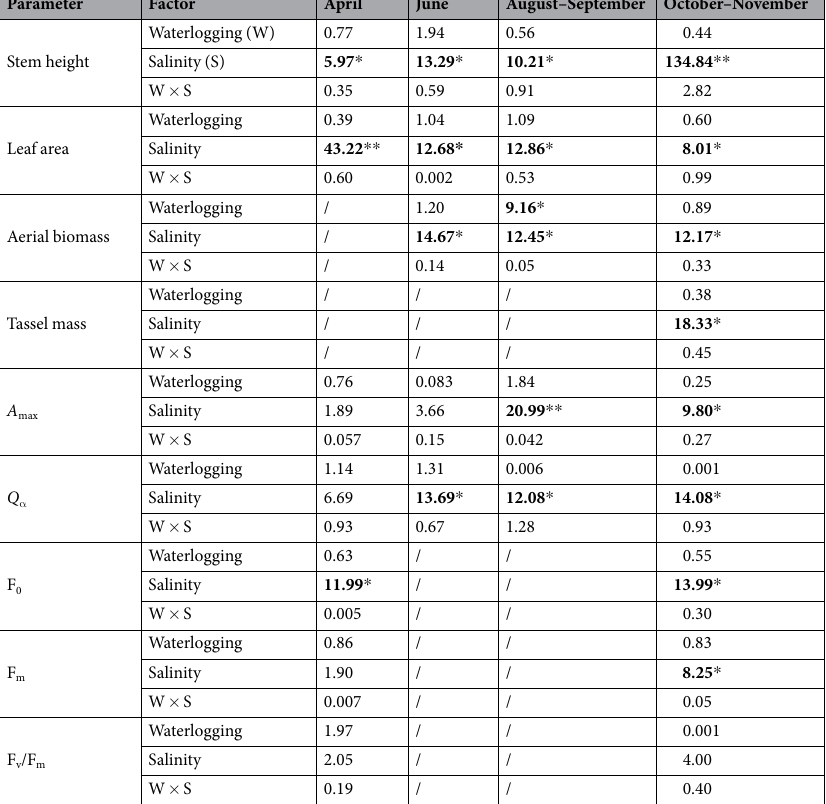
Table 1. Main and interactive effects ( F -values) of waterlogging and salinity on the growth and photosynthetic parameters in P. australis over the growing period. See the Supplementary Table for complete statistical information. * Significance at P < 0.05; ** significance at P <